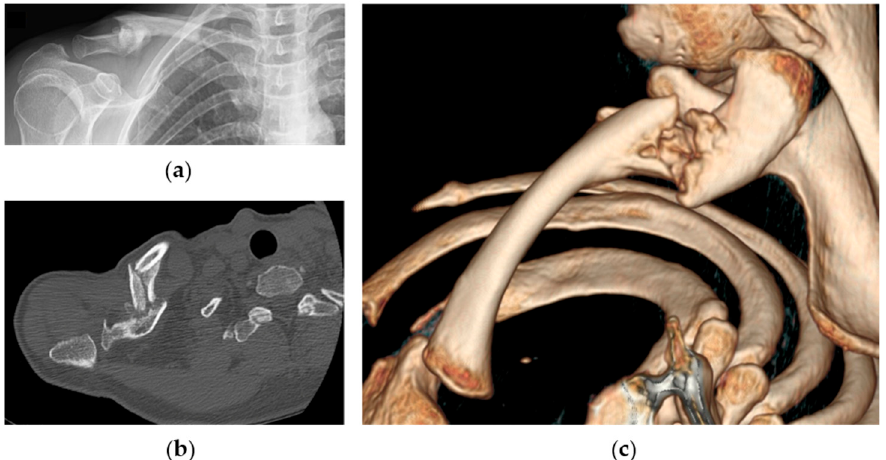
Figure 3. Radiographic images of the same patient showing right clavicle nonunion at 4-month follow-up: ( a ) anteroposterior X-ray view of the clavicle; ( b ) axial CT-scan evaluation of nonunion and; ( c ) 3D reconstruction.